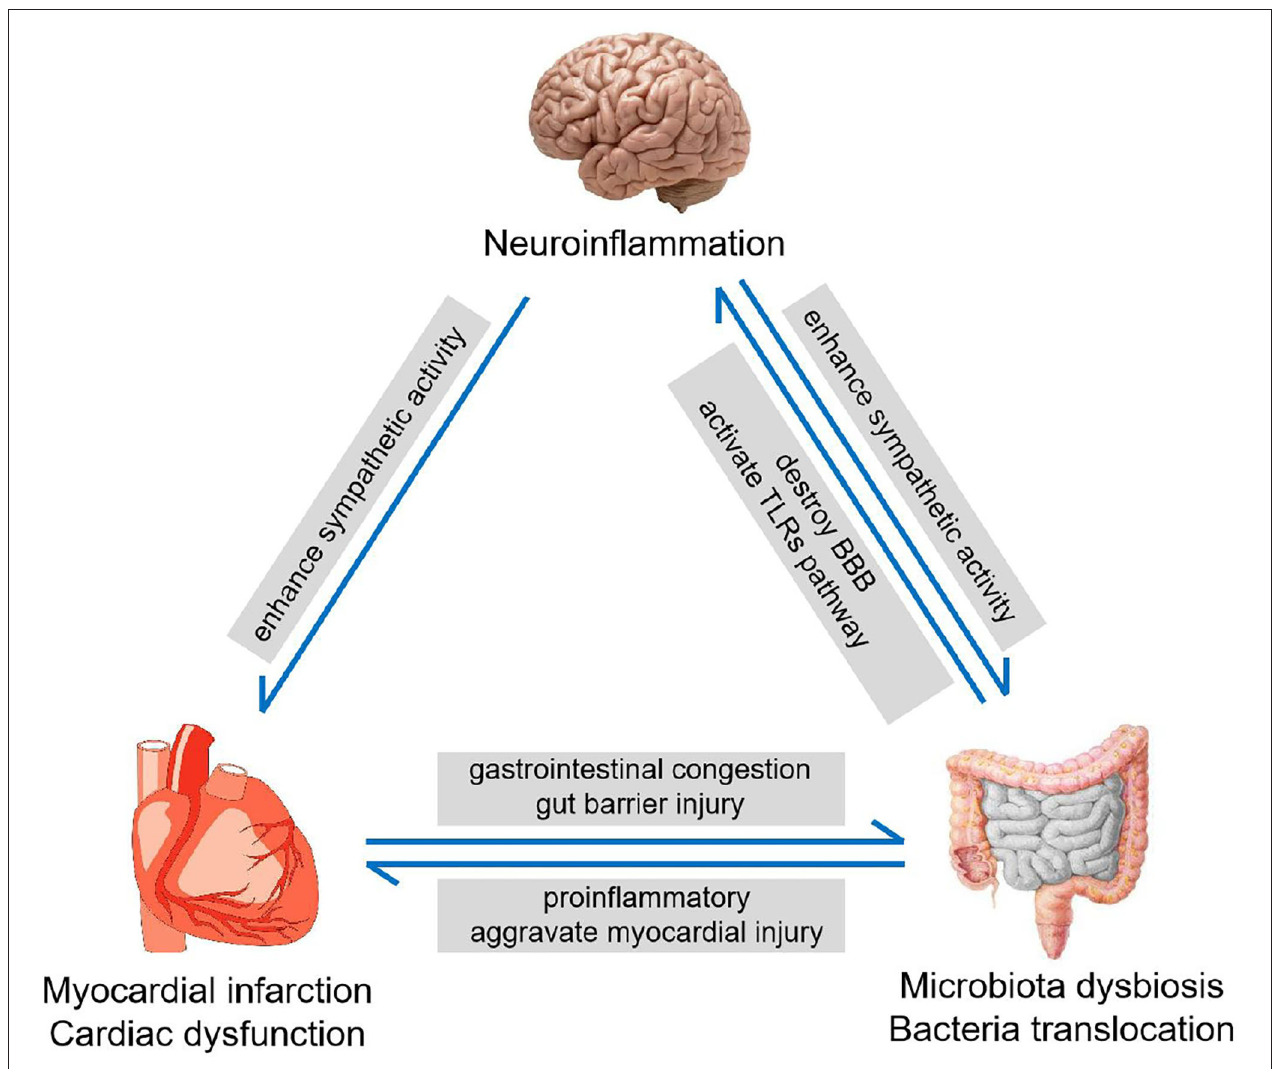
FIGURE 6 | The heart-gut-brain vicious cycle. MI induces the intestinal injury and increases intestinal barrier permeability, leading to microbiota dysbiosis. Microbiota dysbiosis promotes neuroinflammation, which enhances the sympathetic nerve activity and deteriorates myocardial dysfunction.